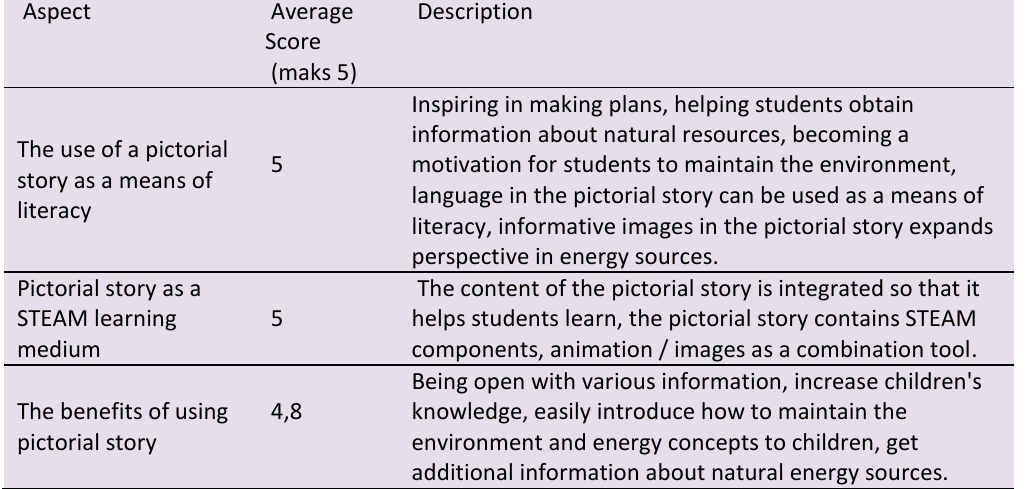
Table 10 . Result of Product Trial with